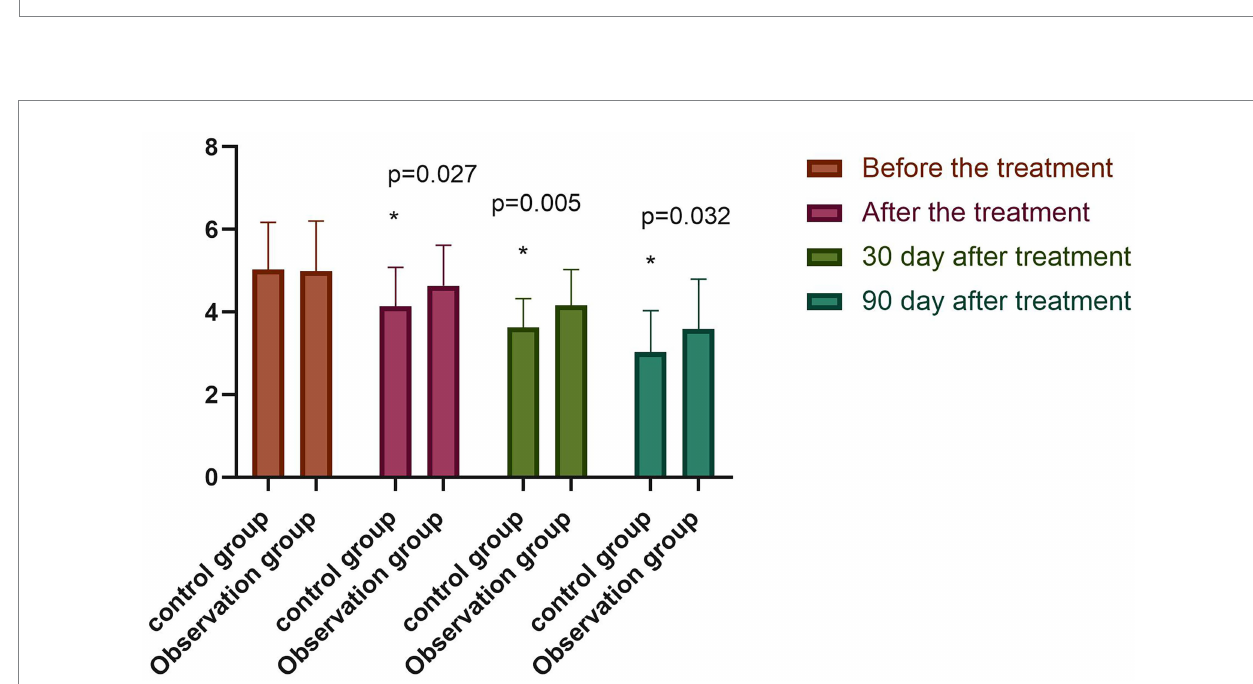
FIGURE 5 Comparison of serum nutritional indexes of both groups before and after the treatment ( − x ± s ). Compared with the group before the treatment, * p <